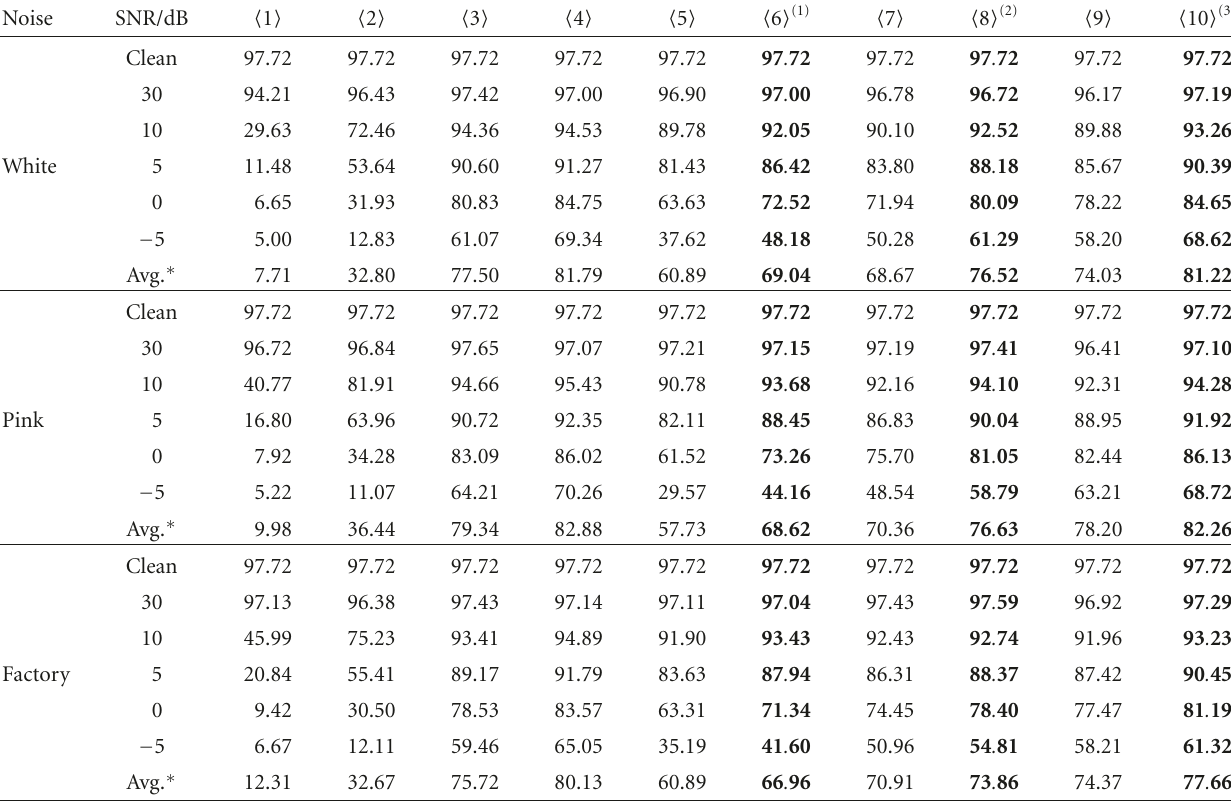
Table 2: Word recognition rate (WRR) (%) from ten methods in di ff erent noise